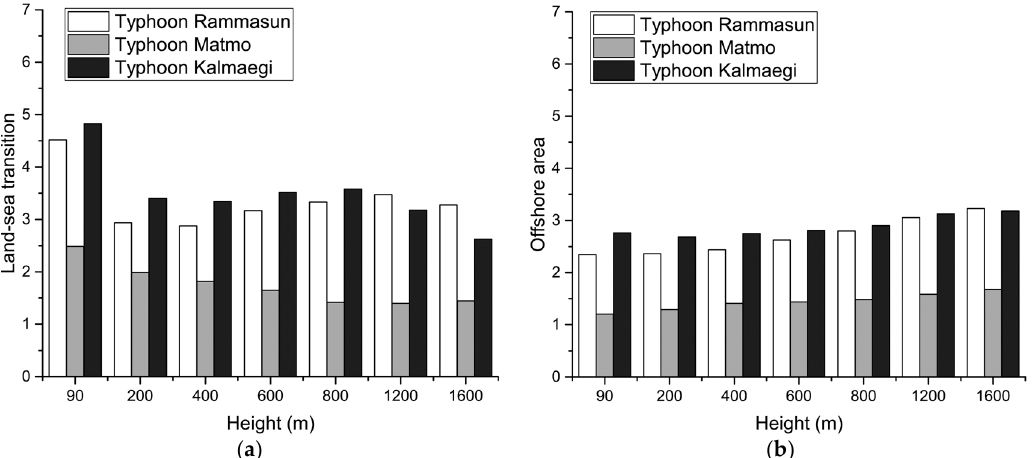
Figure 7. The RMSE of the three typhoon simulations in land-sea transition and offshore area: ( a ) the land-sea transition; and ( b ) the offshore area.